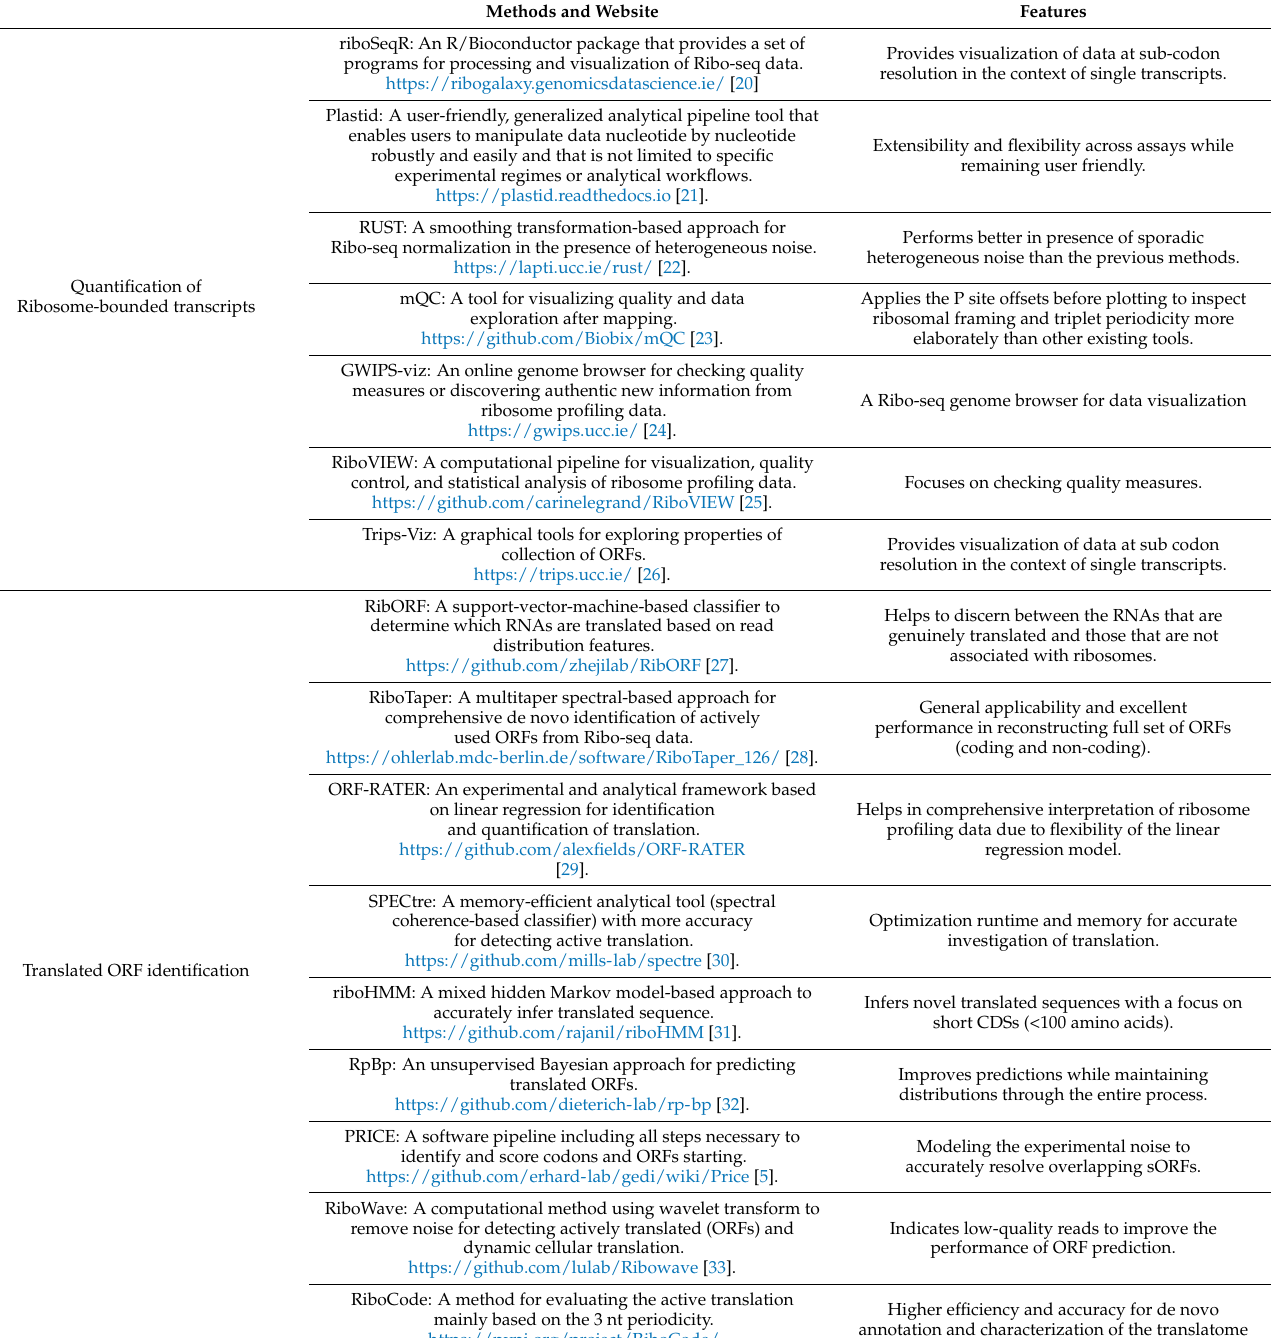
Table 1. A list of computational tools to analyze Ribo-seq